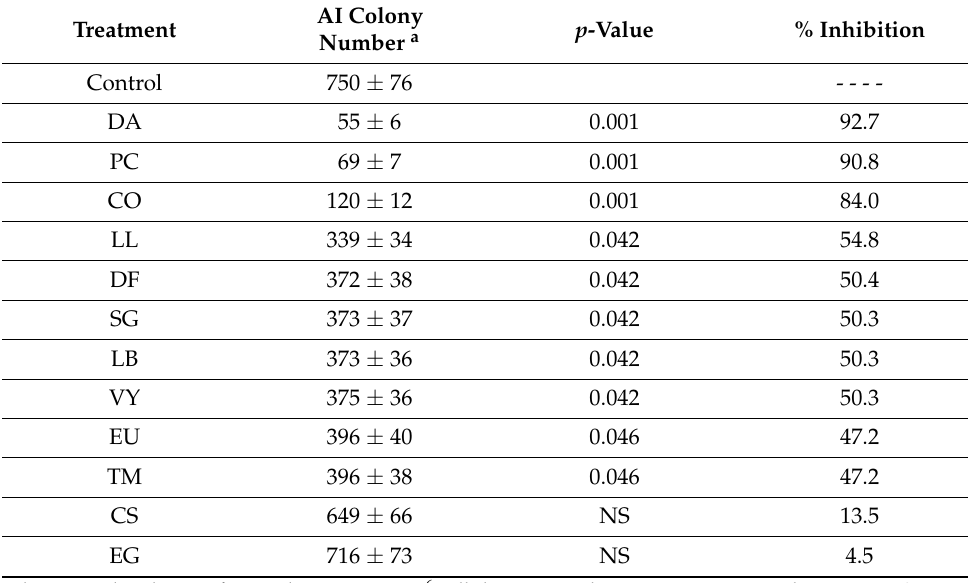
Table 5. Inhibition of anchorage independent colony formation.